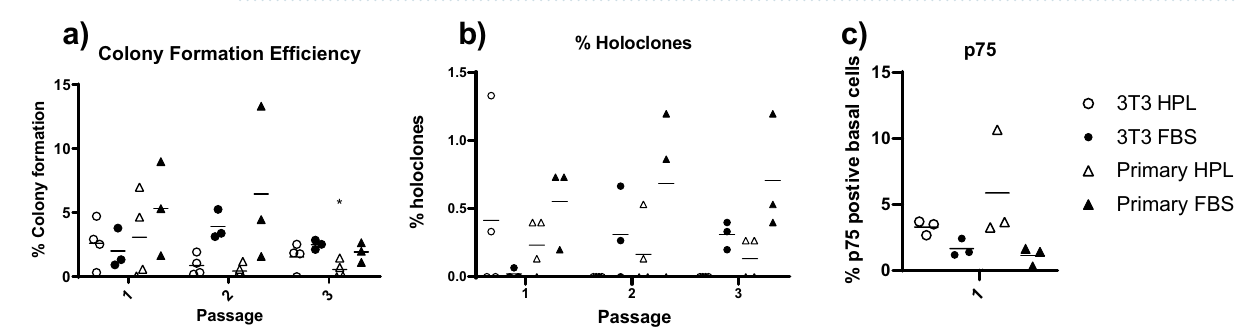
Figure 3. Comparison growth conditions. Porcine epithelial cells grown in the 4 conditions 3T3 FBS Y-27632, 3T3 HPL Y-27632, Primary FBS Y-27632, Primary HPL Y-27632 were compared. Viability ( a ), at passage 2 3T3 FBS is significantly reduced compared to those grown on primary feeder layers, cumulative cell number ( b ), population doubling time, data shows median plus interquartile range ( c ) and cumulative population doublings. Graphs show mean plus SD *P < 0.05, n = minimum of 3. xCELLigence growth at each passage 1 ( d ) passage 2 ( e ) Passage 3 ( f ). Wells were baselined to those containing feeder cells. Cell index is a measure of electrical impedance. Graphs show mean, Green shows 3T3 FBS, Blue shows 3T3 HPL, Black shows Primary FBS and Red shows Primary HPL. There is no significant difference between conditions at 160 h. n = 3.